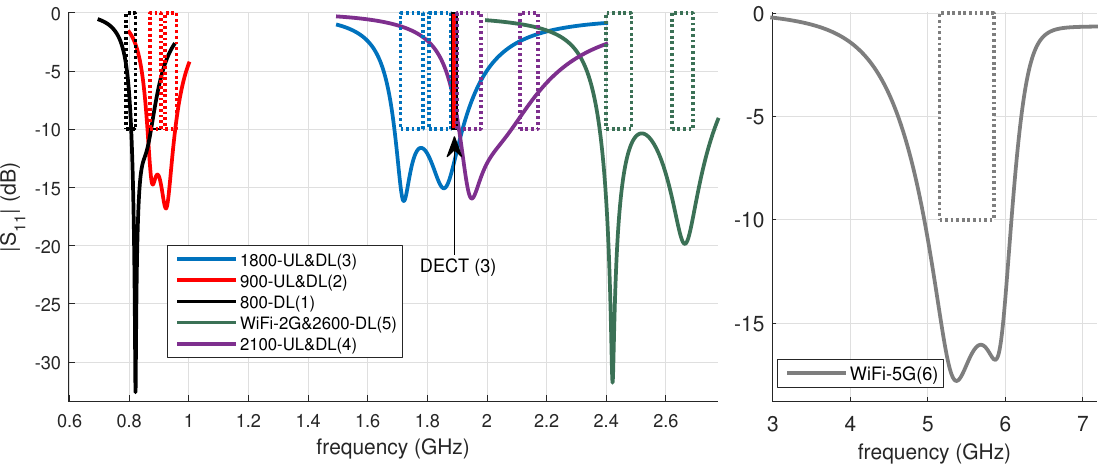
Figure 1. Reflection coefficient of the different antennas, showing good impedance matching for the frequency bands of interest. The numbers in parenthesis are the number of antennas which are listed in Table 1 as antenna